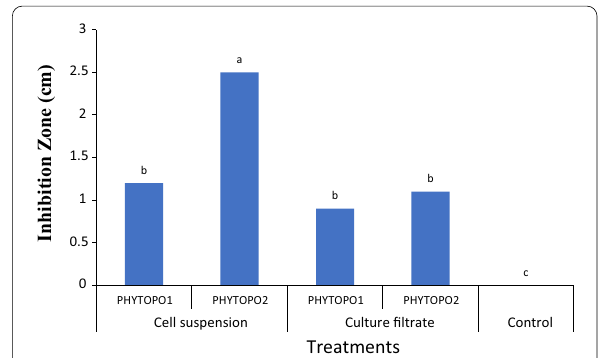
Fig. 1 Effect of two isolates of Pantoea agglomerans as cell suspension or culture filtrate on inhibition zone percentage of Ralstonia solanacearum . According to the LSD test at p in the same column followed by a similar letter are not significantly